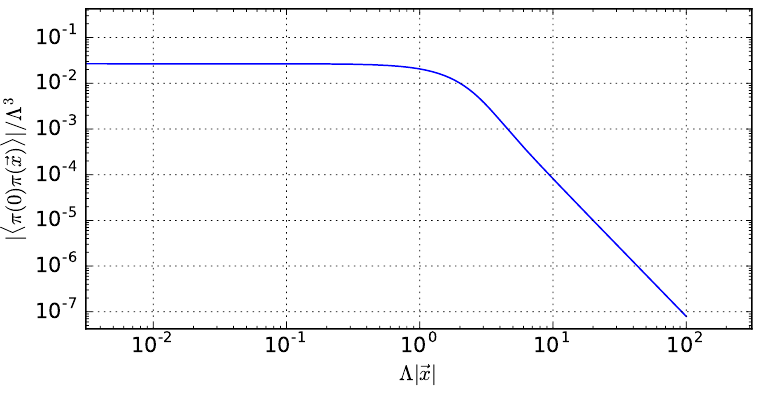
Figure 9 . h (cid:25) (0) (cid:25) ( ~x ) i correlator computed for the 2+1-dimensional bosonic